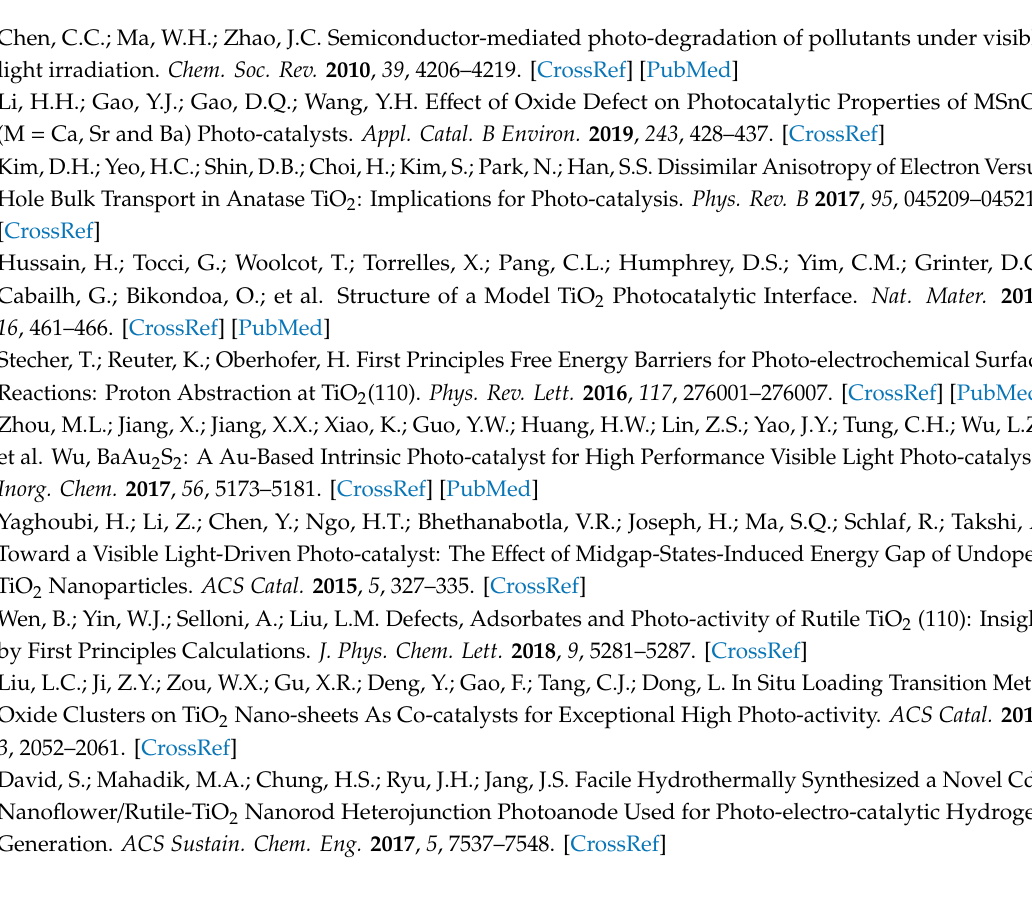
Figure S1: UV-vis absorption of the MO solution as a function of irradiation time for KSb 5 S 8 ; Figure S2: The photograph of the MO solution for di ff erent irradiation time; Figure S3: Cycling performance of KSb 5 S 8 for the degradation of the MO solution under visible light; Figure S4: XRD patterns of KSb 5 S 8 after the cycling performance of photocatalytic degradation of the MO solution; Figure S5: Photodegradation of the MO solution with the additional scavenger under visible light.; Figure S6: The iso-surface of charge density with given energy window of 0.2 eV from the top and bottom of the band edge (a) VBM (b) CBM (iso-surface value 0.002); Figure S7: Optical microscopy image of KSb 5 S 8 from hydrothermal